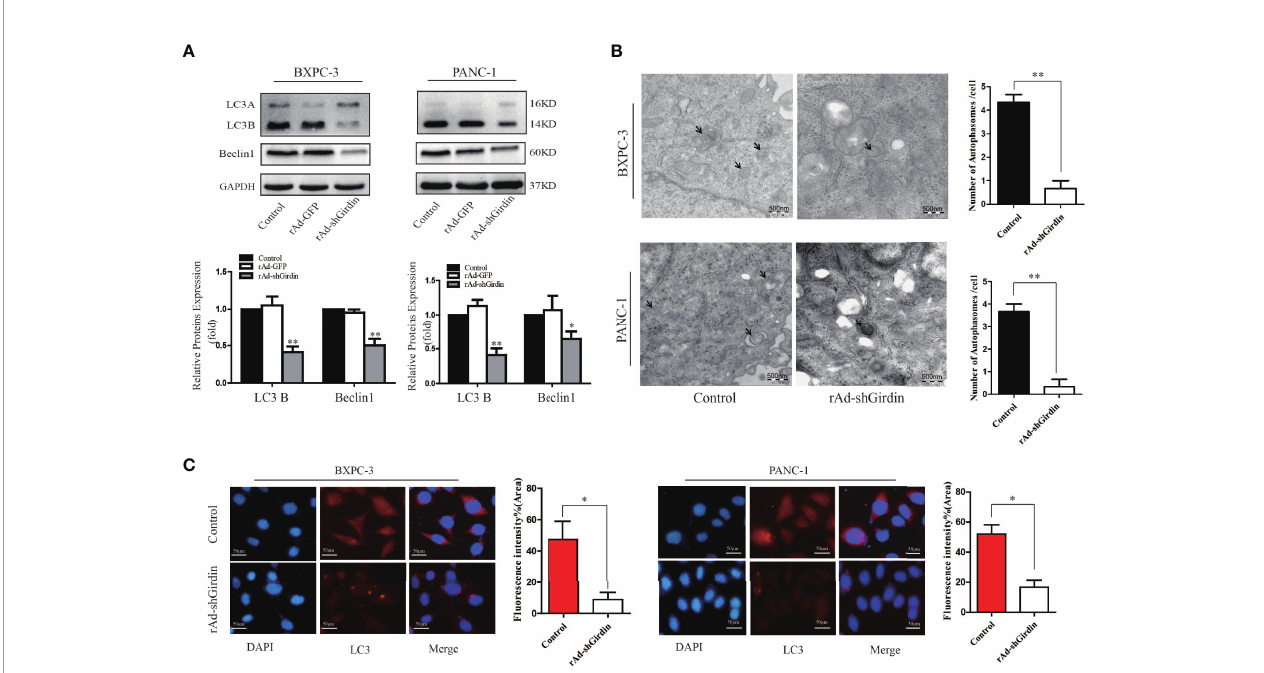
FIGURE 5 | Down-regulation of Girdin reduce the autophagy activity of pancreatic cancer cells. (A) Autophagy related proteins LC3 and Beclin-1 were detected by western blotting after cells were transfected with rAd-shGirdin. Bars represent the SEM. *P < 0.05, **P < 0.01. (B) Autophagosomes were observed by transmission electron microscopy in Bxpc-3 cells and Panc-1 cells after knockdown of Girdin. Cells were cultured with serum-free DMEM. (C) Immuno fl uorescence staining images showed that the LC3 protein level was decreased after infected with